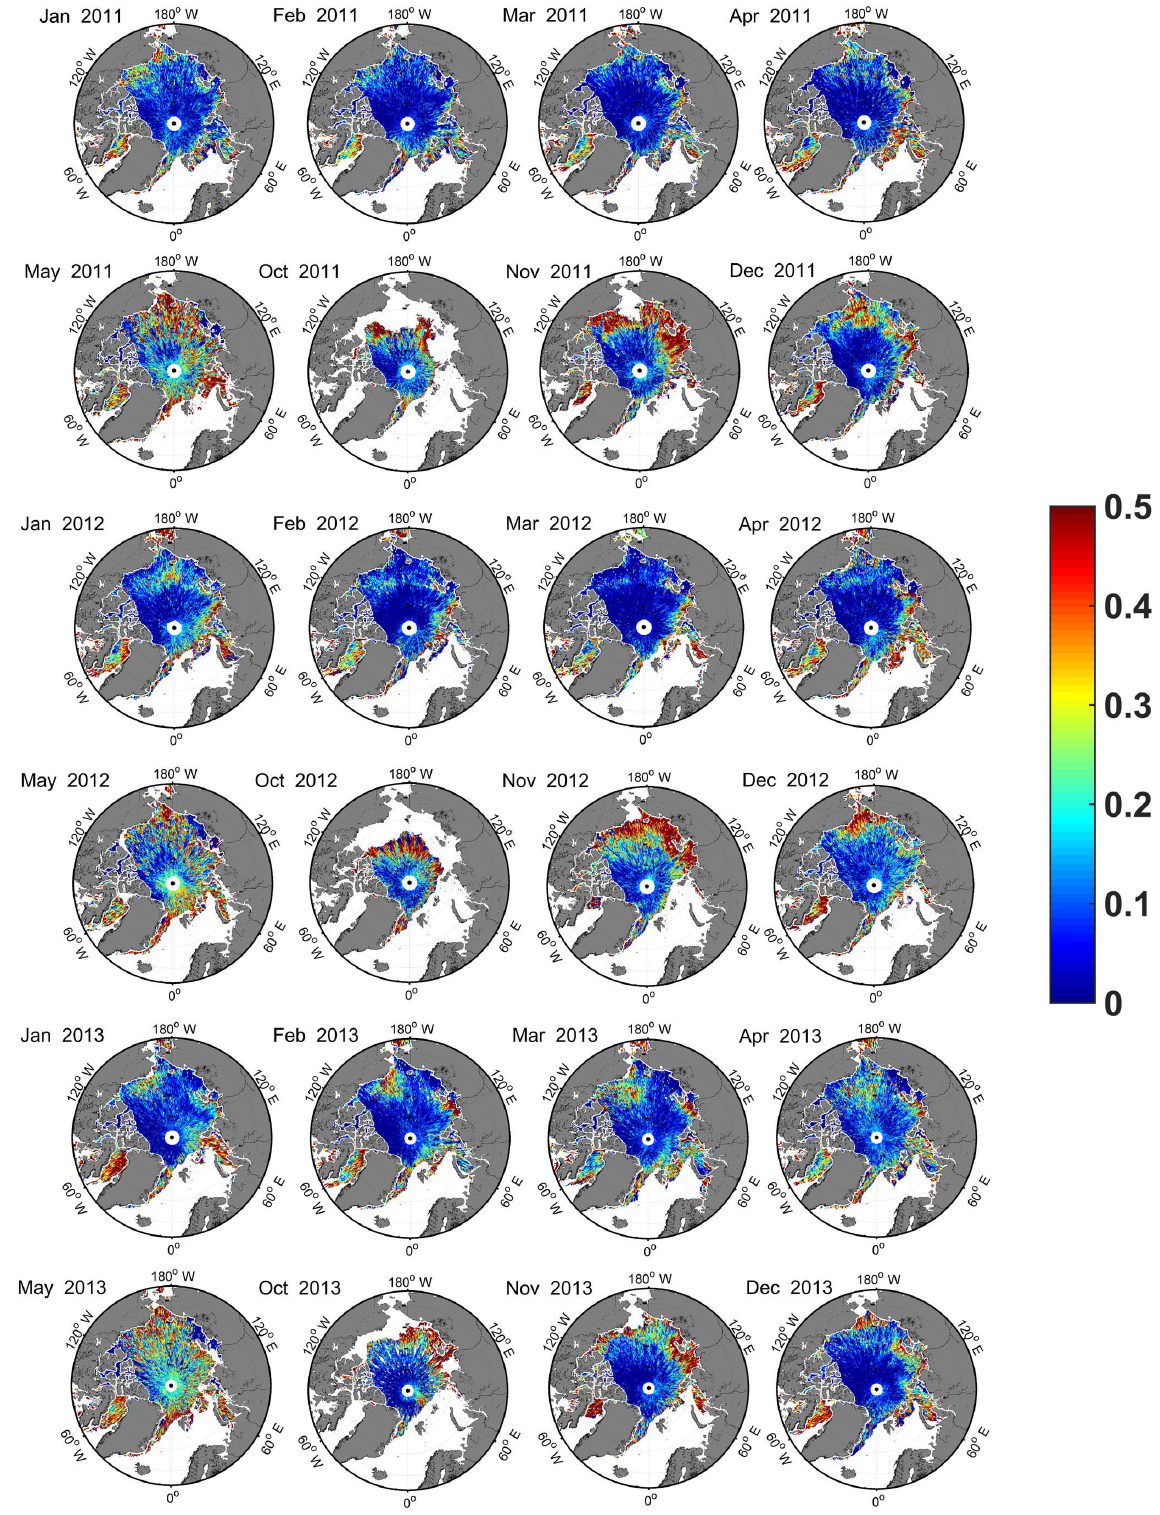
Figure 6. Monthly lead fraction maps based on the waveform mixture algorithm from January to May and October to December between 2011 and 2013. The range of the color bar was set from 0 to 0.5 to emphasize lower